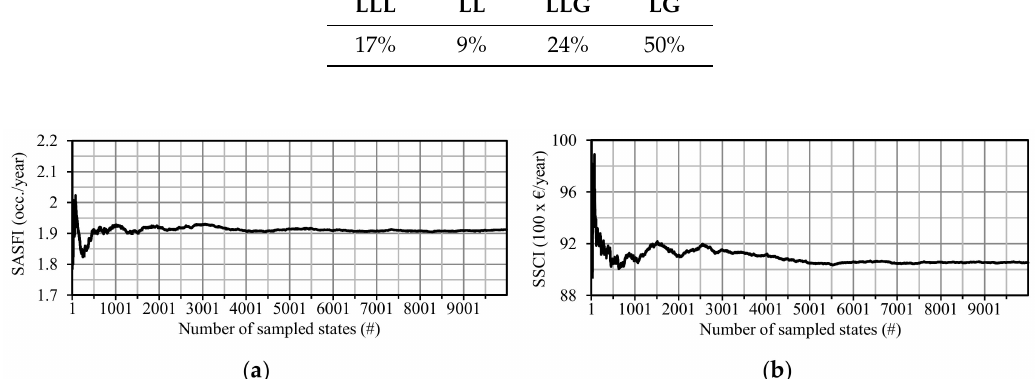
Figure 6. ( a ) Evolution of SASFI versus the number of sampled states for the network under study; ( b ) Evolution of SSCI versus the number of sampled states for the network under